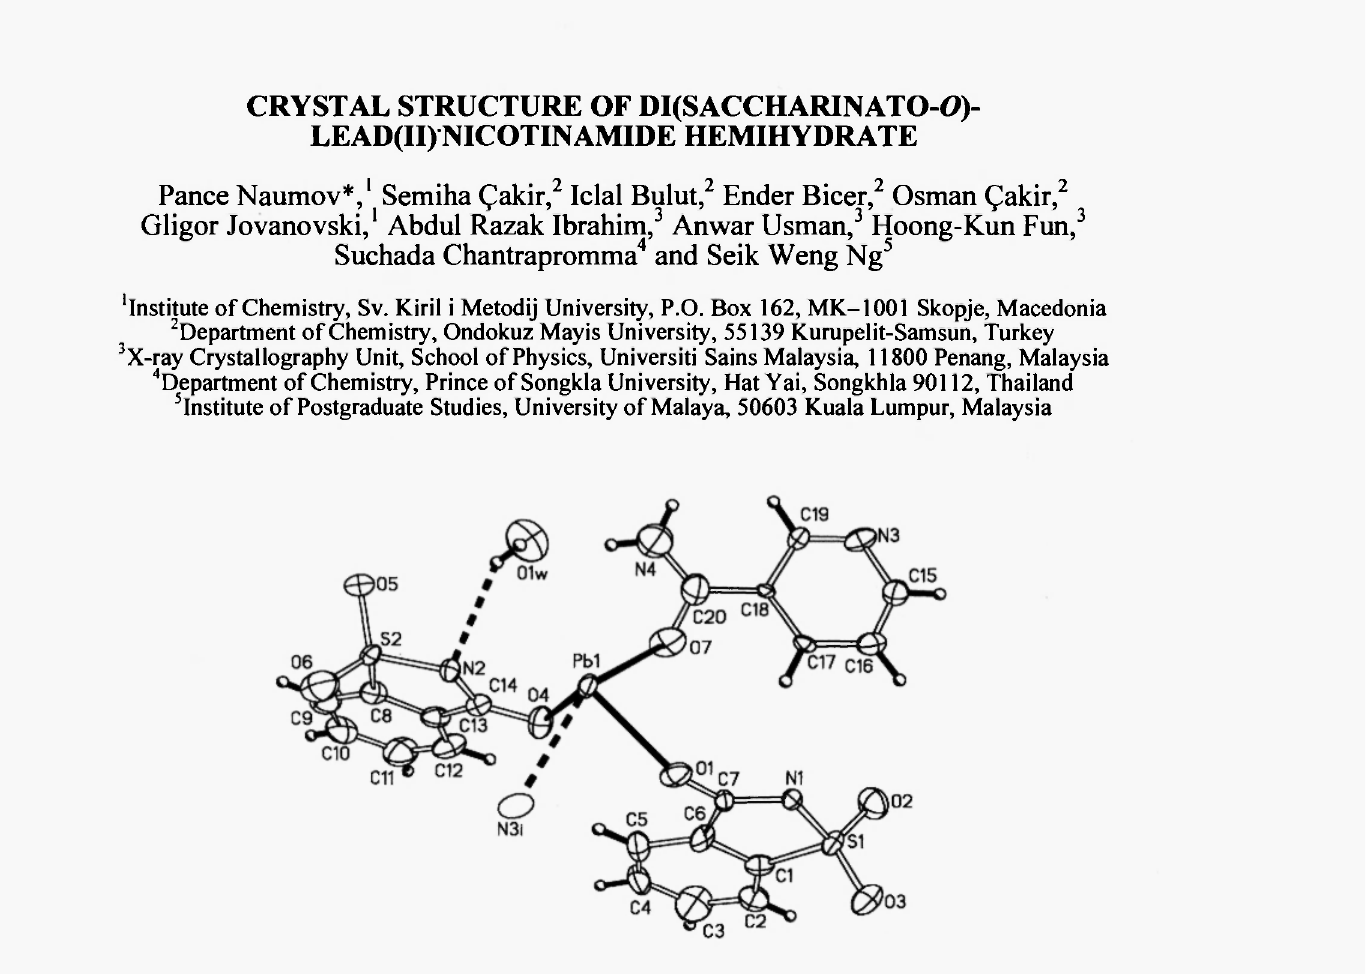
Figure 1. 75% Probability ORTEP plot illustrating the geometry of the lead atom. Selected bond distances and angles: Pbl-Ol 2.421(8), Pbl-04 2.492(8), Pbl-07 2.479(8), Pbl-N3< 2.73(1) Ä;